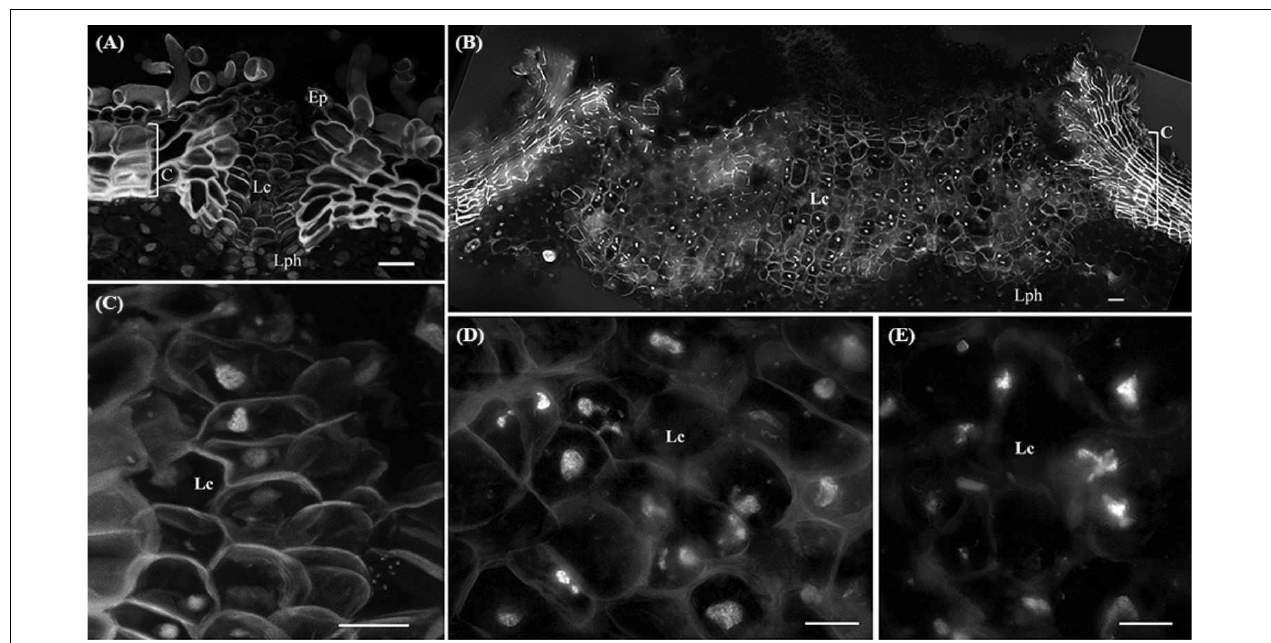
FIGURE 3 | Lenticels found in one-year-old sprigs (A) and in three-year-old sprigs (B) . The lenticels show a higher number of cell layers above the lenticular phellogen that propel the epidermis upwards causing it to fracture [arrowhead in (A) ]. In three-year-old sprigs (B) , the lenticular phellogen localized in much larger areas due to anticlinal divisions and continuous activity during sprig development. The walls of the lenticular cells emit less autofluorescence than cork cells when excited with UV light, indicative of distinct cell wall composition. (C) Nuclei from younger lenticels are whole and round, while from older lenticels are misshapen and fragmented at the innermost regions of the lenticels (D) . (E) At the outermost regions of the lenticels nuclei are highly fragmented as cells are differentiating with portions of chromatin protruding from a central less condensed chromatin mass. DNA was counterstained with DAPI. Bars in (A,B) = 20 µ m and in (C–E) = 10 µ m. Ep, epidermis; Lph, lenticular phellogen; C, cork cells; Lc, lenticular